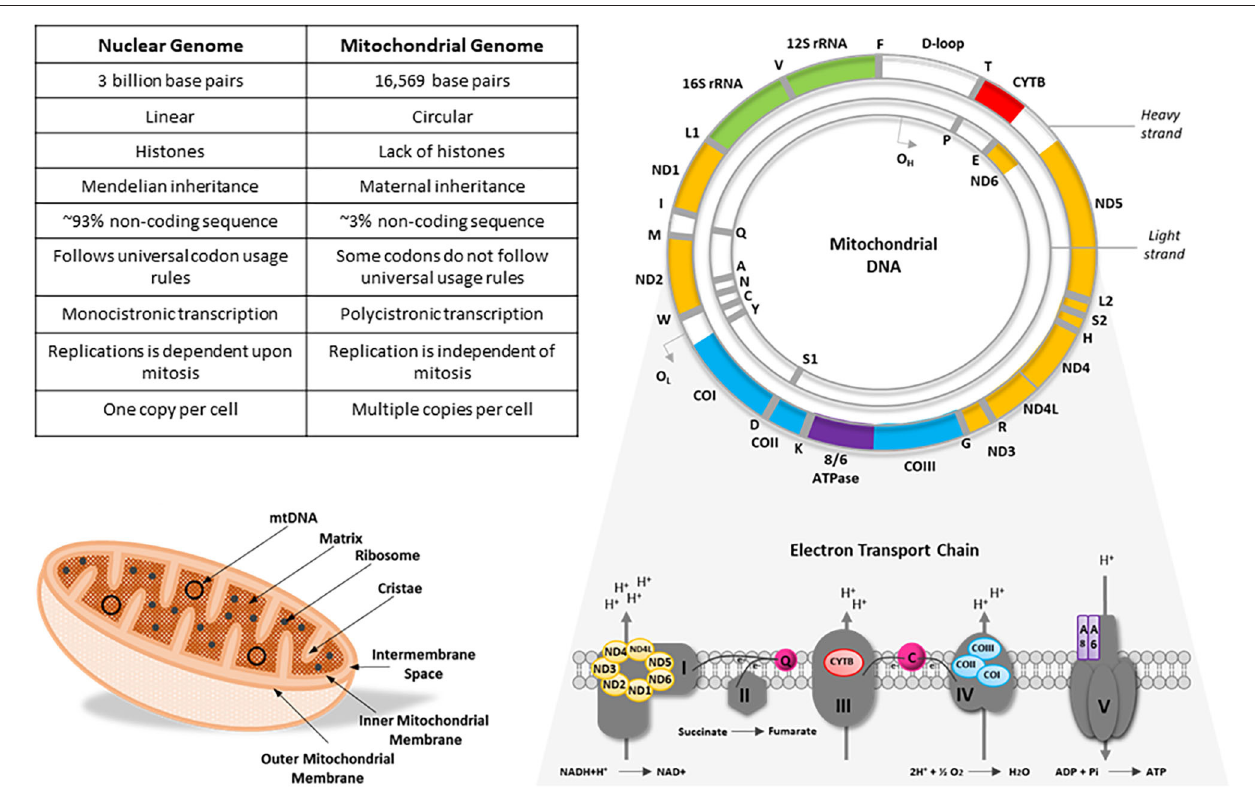
FIGURE 1 | A comparison of the nuclear and mitochondrial genomes alongside an illustrative example of an mtDNA molecule and mitochondrion, with a schematic representation of the mitochondrial respiratory chain. Mitochondrial DNA is a circular, double-stranded molecule that encodes 13 integral subunits of the electron transport chain. Color-coded genes on the mtDNA molecule correspond to their cognate subunits on the electron transport chain. CO, cytochrome c oxidase; CYTB, cytochrome b ; IMS, intermembrane space; ND, NADH dehydrogenase; O H , H-strand origin of replication; O L , L-strand origin of replication; Q, ubiquinone; rRNA, ribosomal RNA. Figure adapted from DiMauro and Schon (2003) and Penman et al.